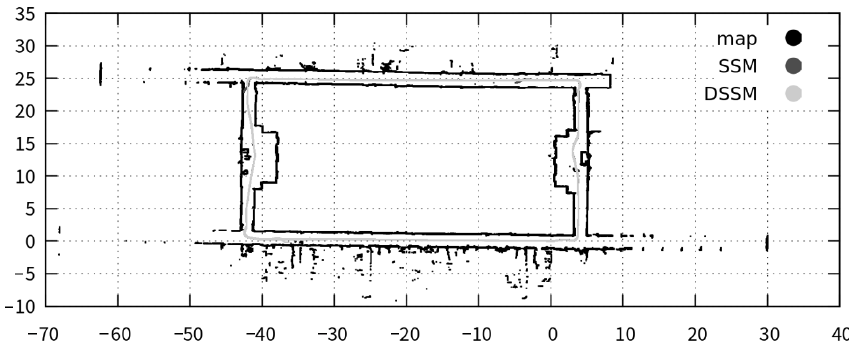
Figure 10. Trajectories of the robot.